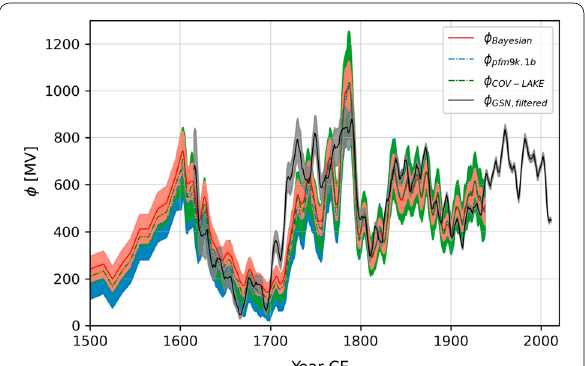
Fig. 11 A close-up comparison between different reconstructions of solar activity with φ GSN . The 9-year running average version of φ GSN is depicted with mean (black solid line) and 2-sigma uncertainty (grey shading). The red line and red shading depict the mean and 2-sigma uncertainty of the Bayesian 14 C-based reconstruction. The blue dashed line and blue shading, and the green dashed line and green shading depict the means with their 2-sigma uncertainty of the conventional reconstructions where the influences of GDM were removed using the pfm9k.1b and COV-LAKE models, respectively